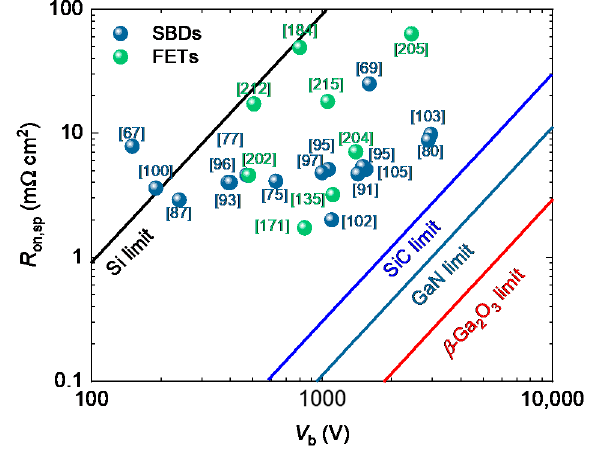
Figure 15. Benchmark of the V b ~ R on,sp relationship for the aforementioned